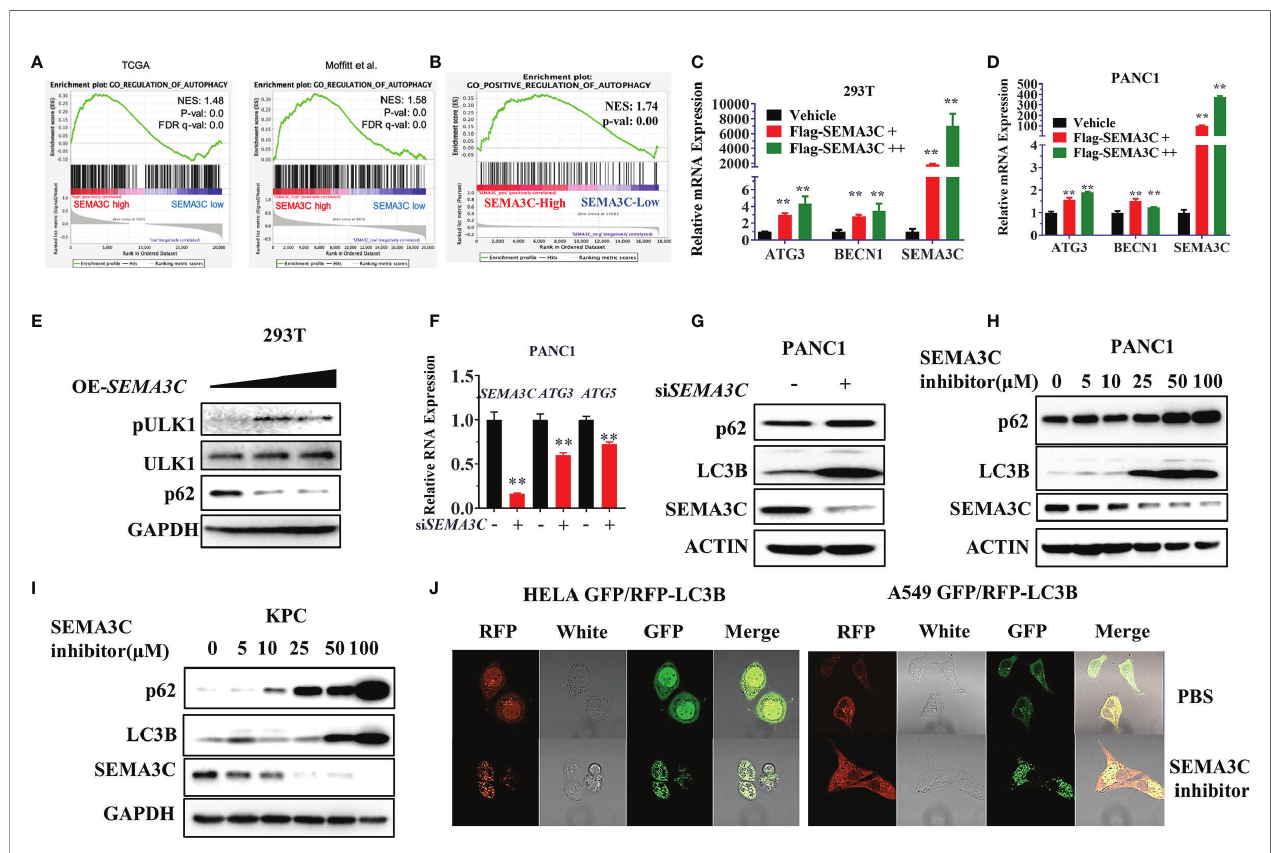
FIGURE 4 | (A, B) The correlation between SEMA3C expression and autophagy signaling pathway analyzed with TCGA and CRA001160 data by GSEA software. (C, D) Overexpression of the SEMA3C in 293T and PANC1 cells for 48 hours, autophagy induction genes mRNA levels were detected by the qPCR assay. (E) Overexpression of SEMA3C in 293T cells for 48 hours, autophagy initial protein ULK1 phosphorylation status and total protein were detected. (F) Knockdown of SEMA3C in PANC1 cells induces autophagy initial gene ATG3 and ATG5 mRNA expression. (G) Knocking down the SEMA3C in PANC1 cell lines, p62, and LC3B protein levels were detected by western blot. (H, I) Dose dependent on p62 and LC3B protein level after treatment by the SEMA3C inhibitors. (J) GFP-RFP-LC3B labeled cells were treated by the SEMA3C inhibitor, the LC3B puncta observed by the confocal image. Data are representative of three independent experiments. T-tests for the measurements between the two groups; **P <